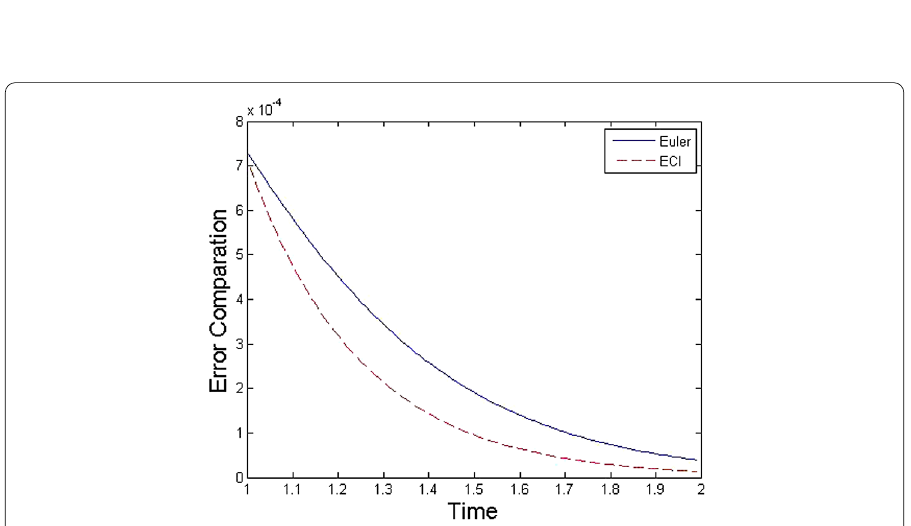
Figure 2 Comparison of the numerical solutions in the time interval [1,2] for two methods